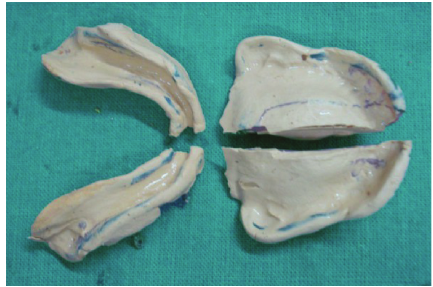
Figure 3: Final impression in sectional tray.